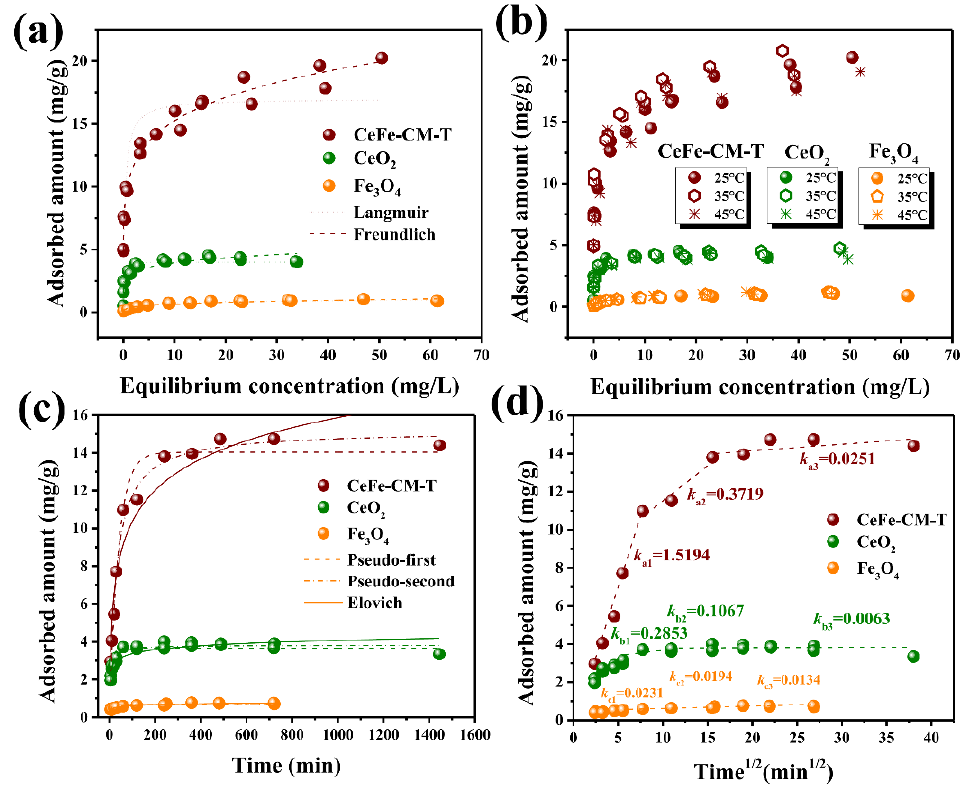
Figure 5. Adsorption isotherm curves of phosphate onto CeFe-CM-T, CeO 2 , and Fe 3 O 4 at ( a ) 25 ◦ C and ( b ) different temperatures (25 ◦ C, 35 ◦ C and 45 ◦ C); ( c , d ) adsorption kinetics of phosphate onto CeFe-CM-T, CeO 2 , and Fe 3 O 4 .